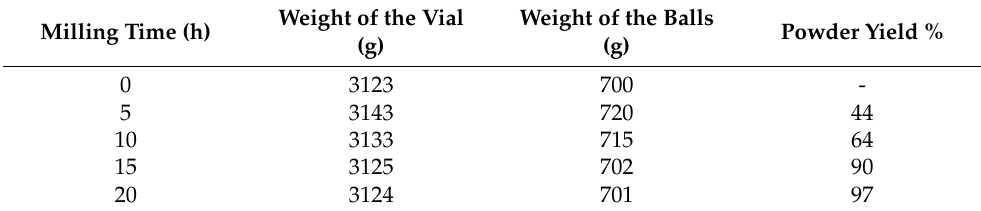
Table 2. Effect of milling time on powder yield of NiMnFeCu powders.